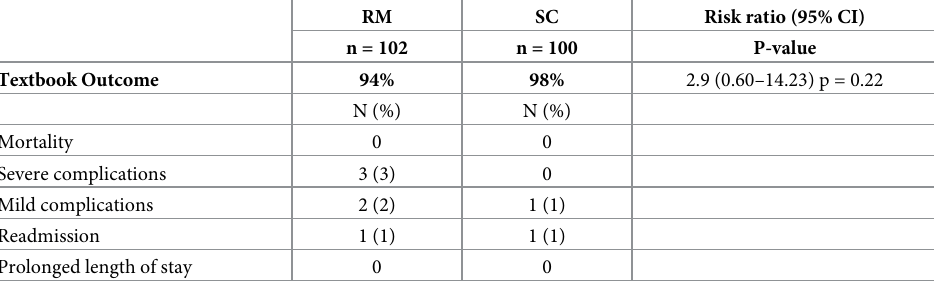
results were statistically inconclusive [27]. Further, Textbook Outcomes of both groups were above the Dutch average of 88.7% (RM 5.3% and SC 9.3%). Table 2. Primary endpoint (textbook outcome) according to ITT